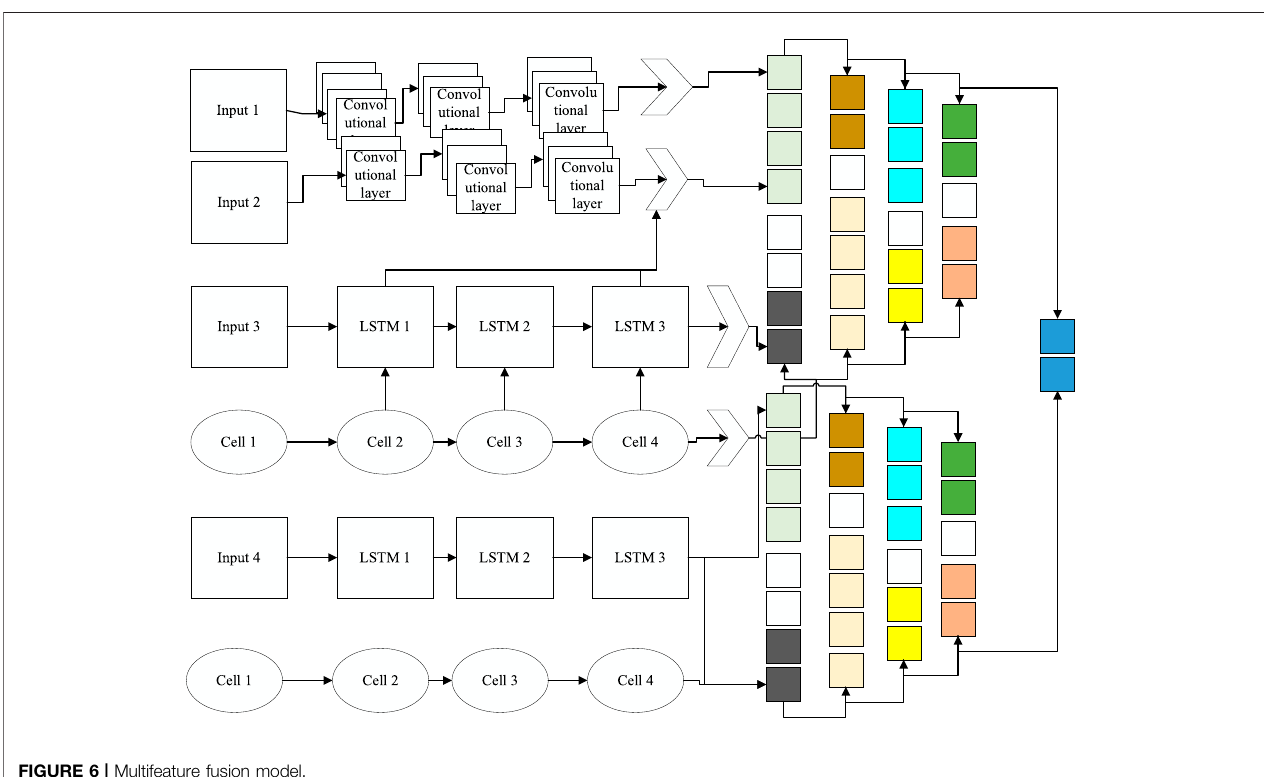
FIGURE 6 | Multifeature fusion model.